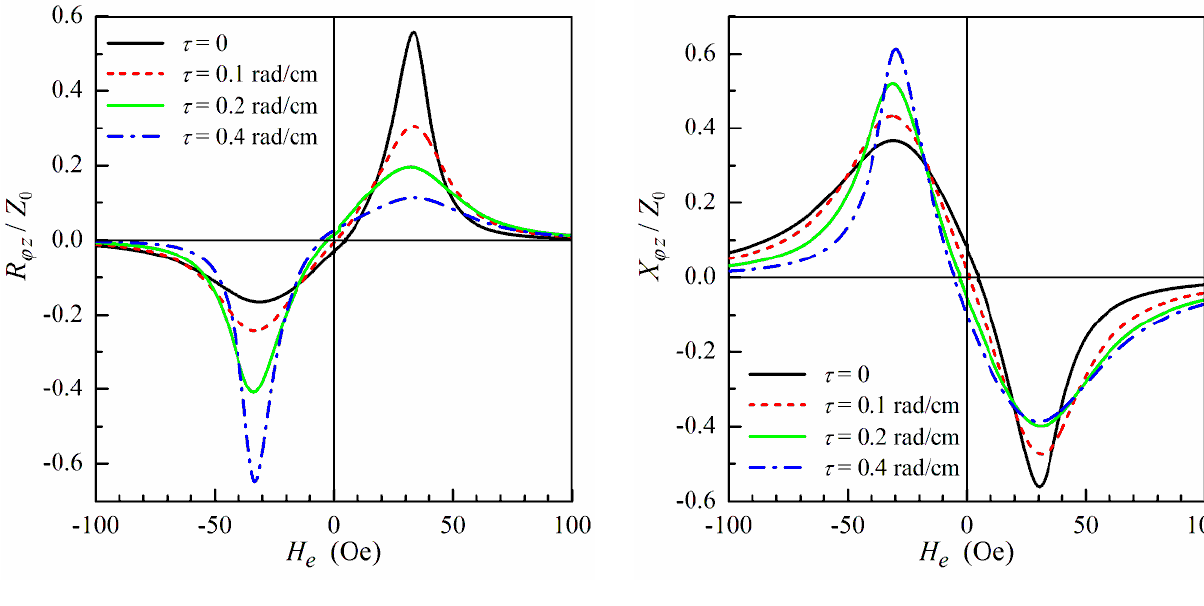
Figure 9. ( a ) The real part R ϕ z and ( b ) the imaginary part X ϕ z of the ODMI as a function of the external field H e at f = 100 MHz and I b = 30 mA for different values of the angular displacement per unit length τ . Magnetostriction coefficient λ s = 40 × 10 − 6 , shear modulus G = 50 GPa, other parameters used for calculations are the same as in Figure 3.